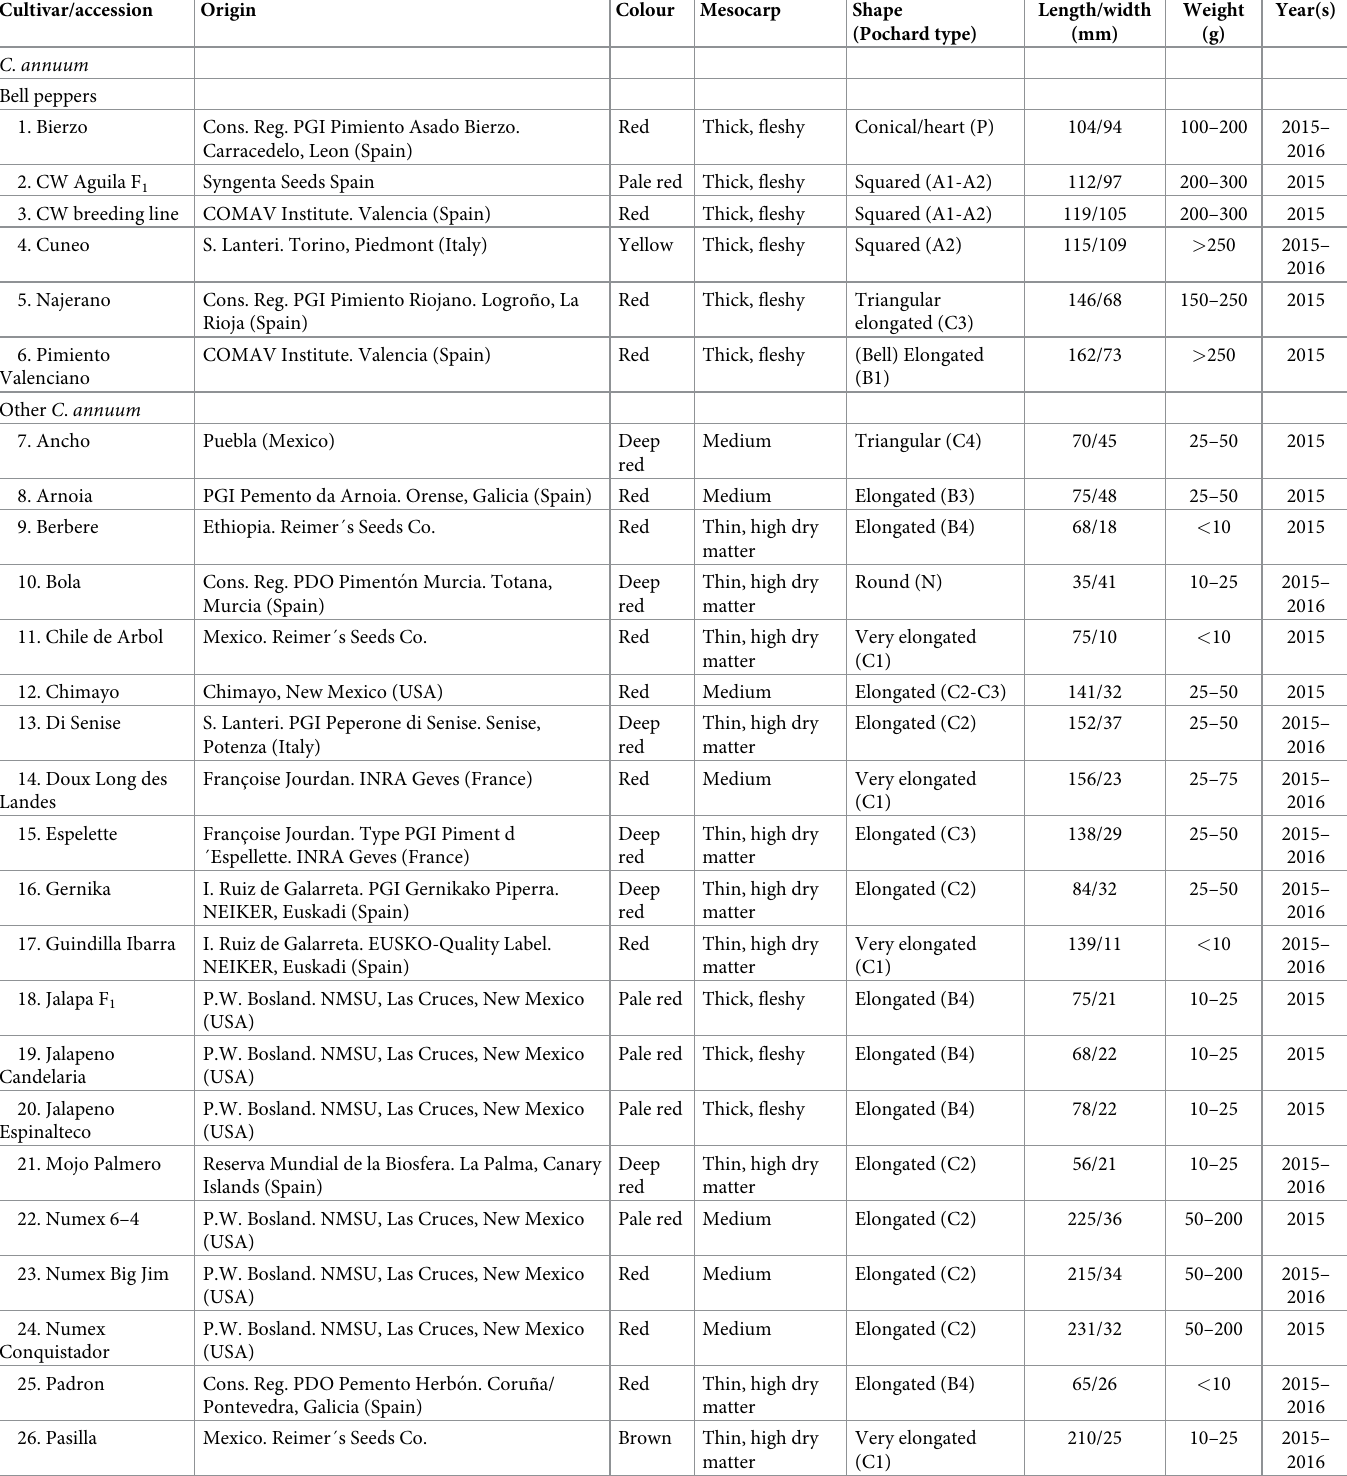
Table 1. List of accessions used, with local name, origin and fruit traits, and years of evaluation in the experiment.